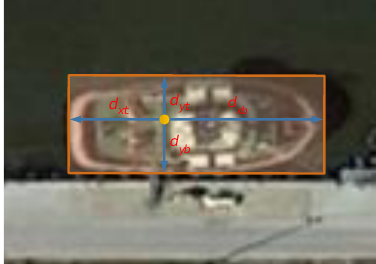
Figure 4. The offset of the anchor-free detection branch. The distances from the current location to the left, right, top, and bottom side of the bounding box are represented by d xt , d xb , d yt , and d yb , respectively.